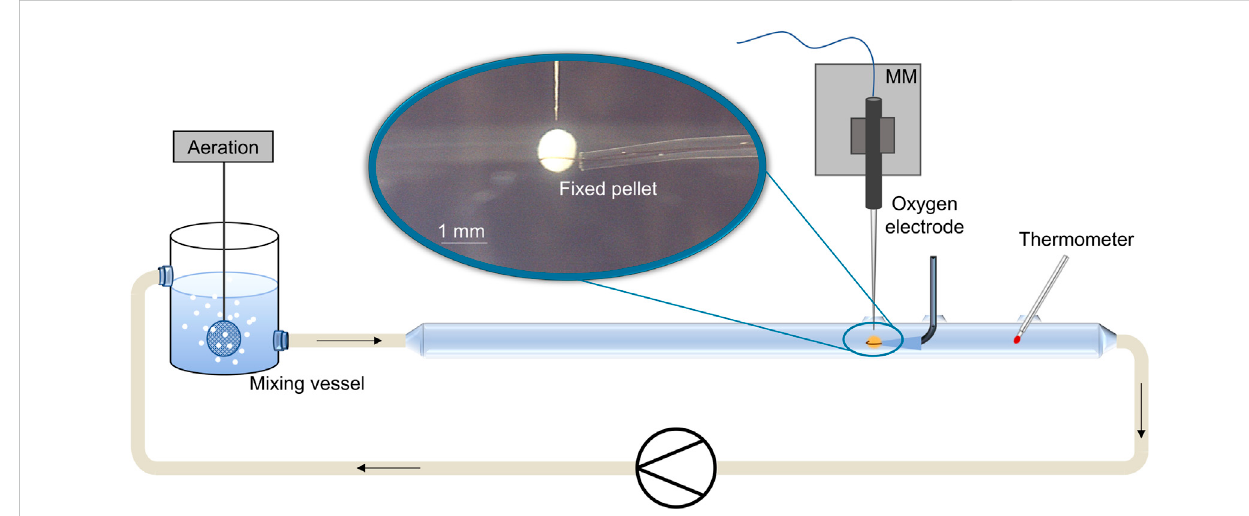
FIGURE 1 Scheme of the experimental setup for oxygen micropro fi ling in biopellets (blue encircled close-up) of fi lamentous microorganisms. Pellet analysis occurs in a glass tube (laminar fl ow conditions) with the help of oxygen micro-sensors fi xed on a software-controlled micromanipulator (MM). Oxygen concentration is measured in 10 µm step sizes inside the